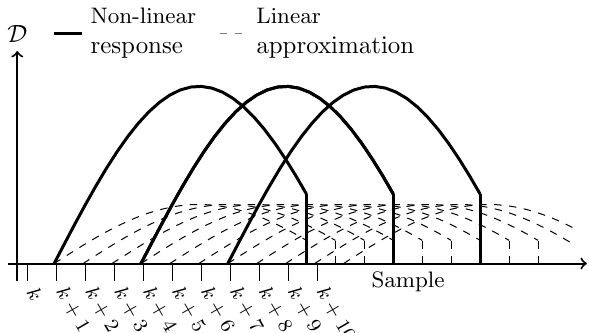
Figure 13: Discretization of displacement